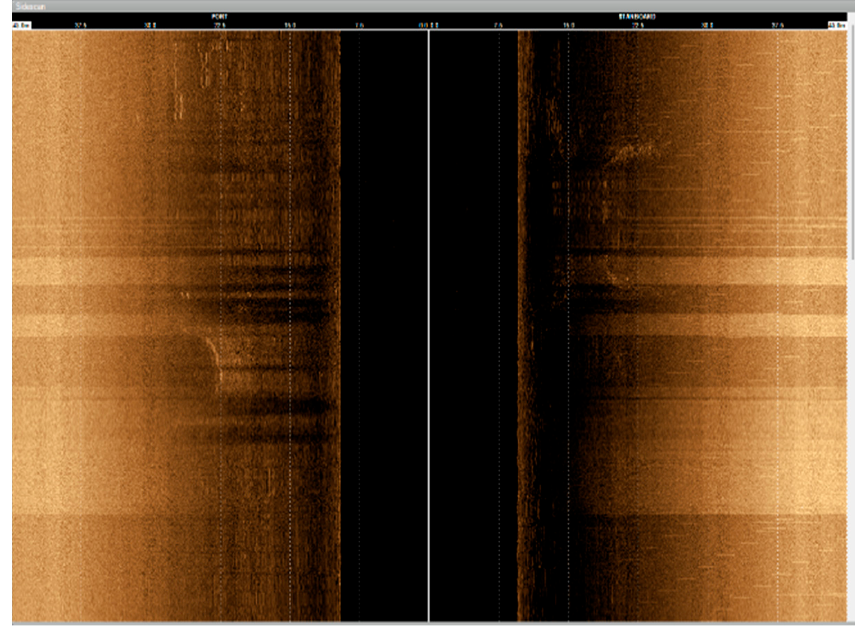
Figure 11. Sonar image with initial human involvement in data collecting process.